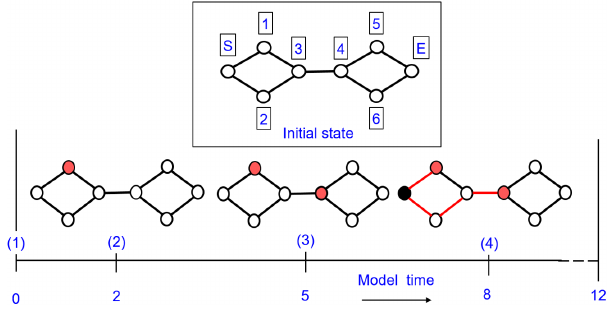
FIG. 9. Example for state transitions leading to a missed protection shutdown scenario in the open signal path